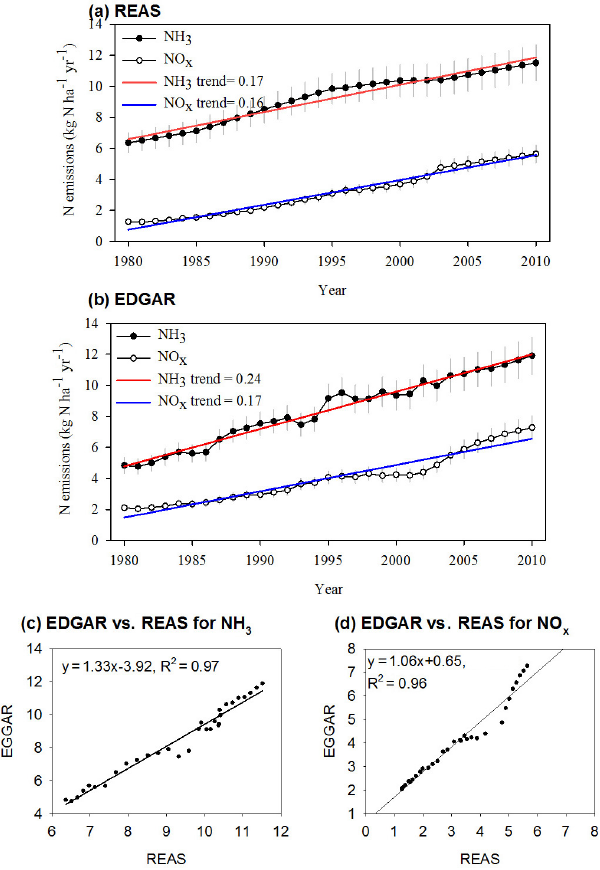
Figure 2. The NO 2 and NH 3 emissions over China. Panel (a) shows the NO 2 and NH 3 emissions over China from 1980 to 2010 from REAS, (b) represents the NO 2 and NH 3 emissions over China from 1980 to 2010 from EDGAR, (c) demonstrates the relationship of NO 2 emissions over China from REAS and EDGAR and (d) shows the relationship of NH 3 emissions over China from REAS and